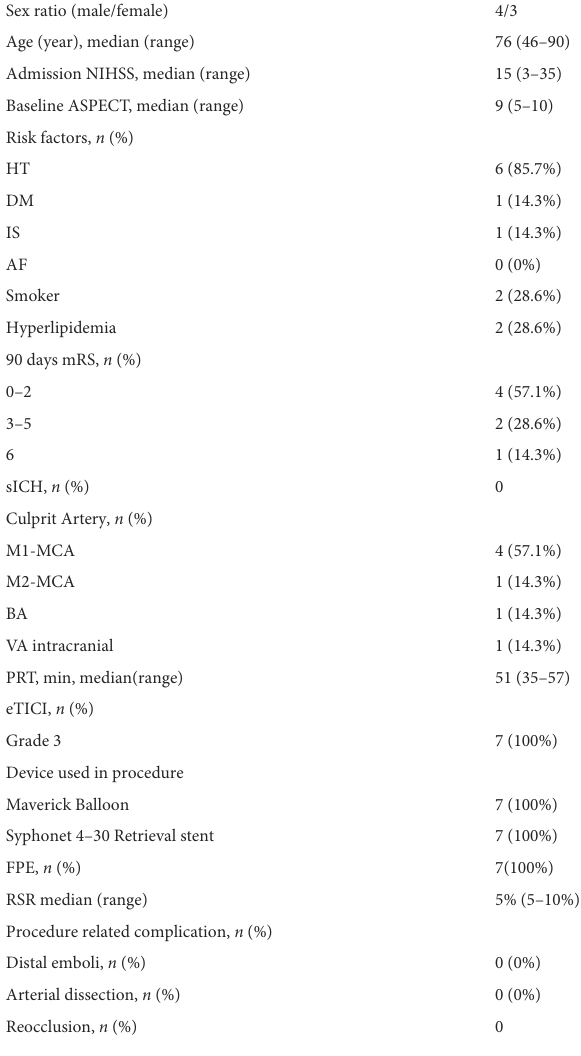
TABLE 1 Summary of patient characteristics and clinical and radiological